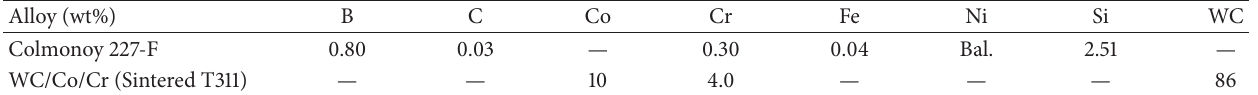
Table 1: Nominal chemical composition of the powders used in experiments.